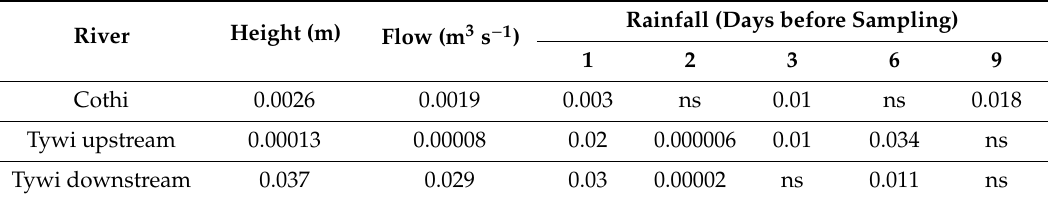
Table 2. Influence ( p values) of river height, river flow (at the time of sampling) and rainfall (on days preceding sampling) on the presence of Map in rivers Tywi and Cothi. (ns: not significant).